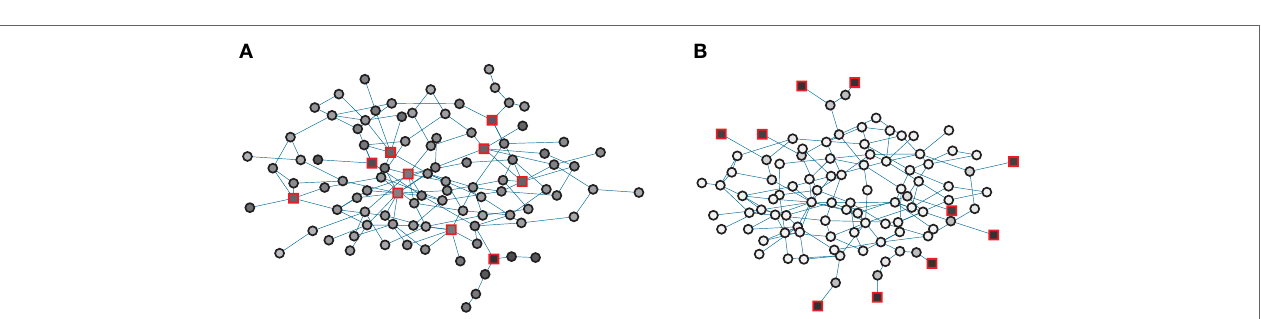
FIGURE 2 | Examples of optimized control for a network of N = 100 nodes and L = 288 links for low q = 0.01 (panel A ) and high q = 0.5 (panel B ). The networks are constructed via a configuration model with P ( k ) ∝ k (cid:0) (cid:11) with (cid:11) = 3. Red boxes indicate controlled nodes, circles indicate ordinary nodes. Interior colors give relative control on a sliding scale from white (weakest control) to black (strongest control). The average opinion is ⟨ s ⟩ = 0.72 (panel A ) and ⟨ s ⟩ = 0.034 (panel B ).